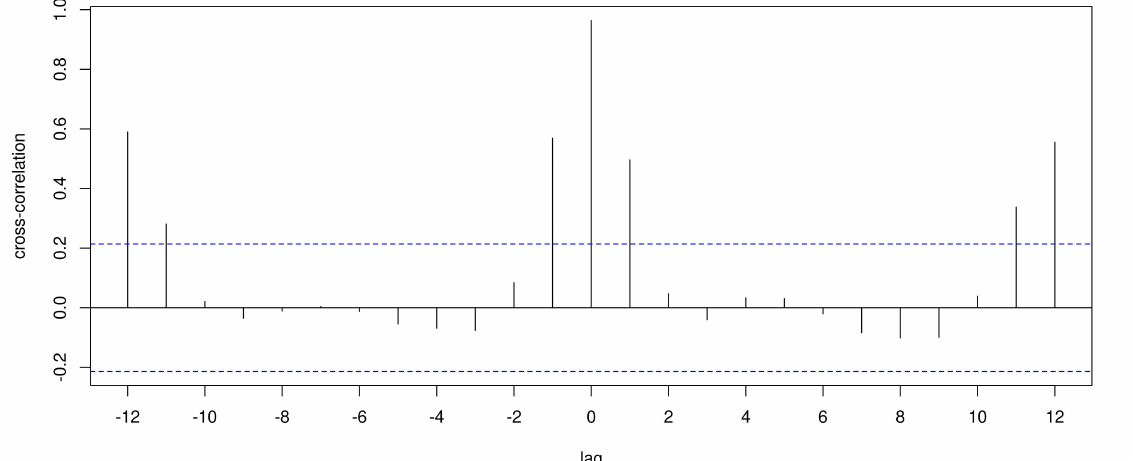
Figure S2 – Cross-correlation of number of fire points per month sensed by MODIS and VIIRS sensors for the period